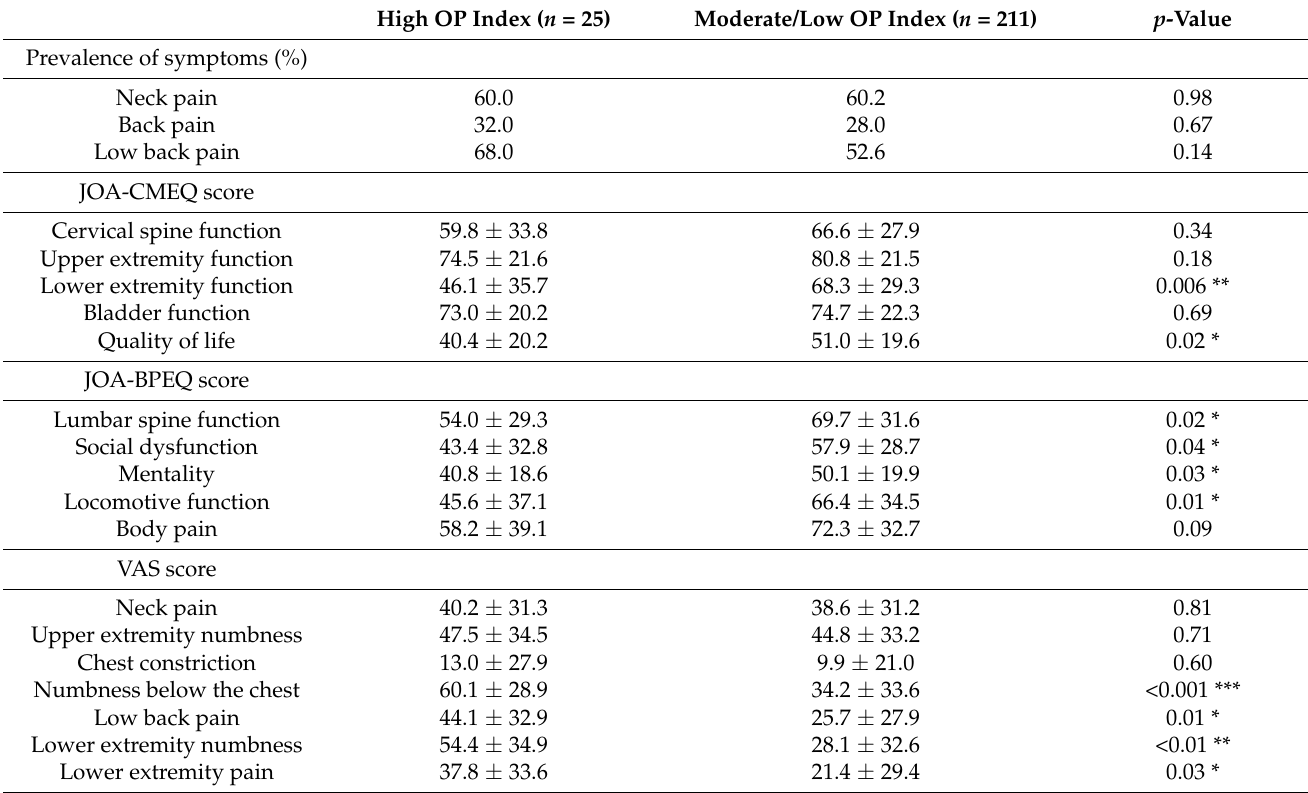
Table 2. Clinical characteristics in patients with ossification of the posterior longitudinal ligament according to whether the OP index was high or